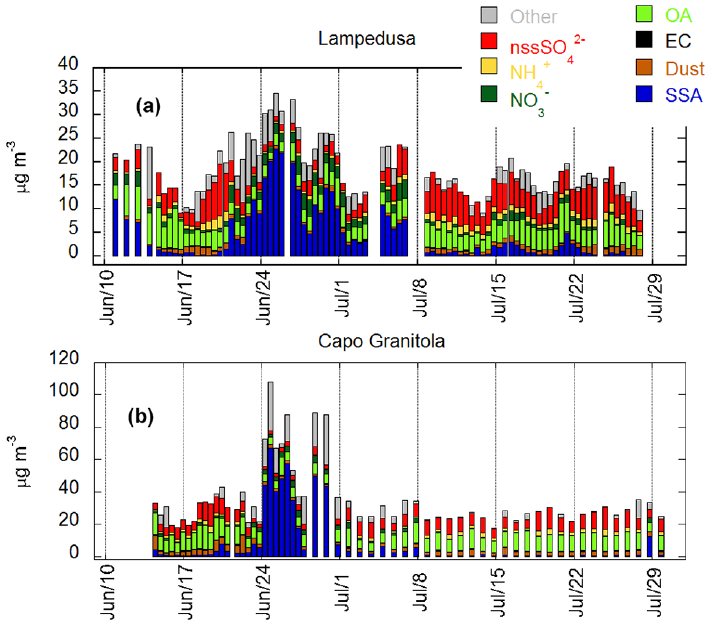
Figure 2. Time series of the main aerosol components at LMP (a) and CGR (b) . Note the different vertical scales of the graphs. OA, EC, and SSA stand for organic aerosol, elemental carbon and sea salt aerosol, respectively.